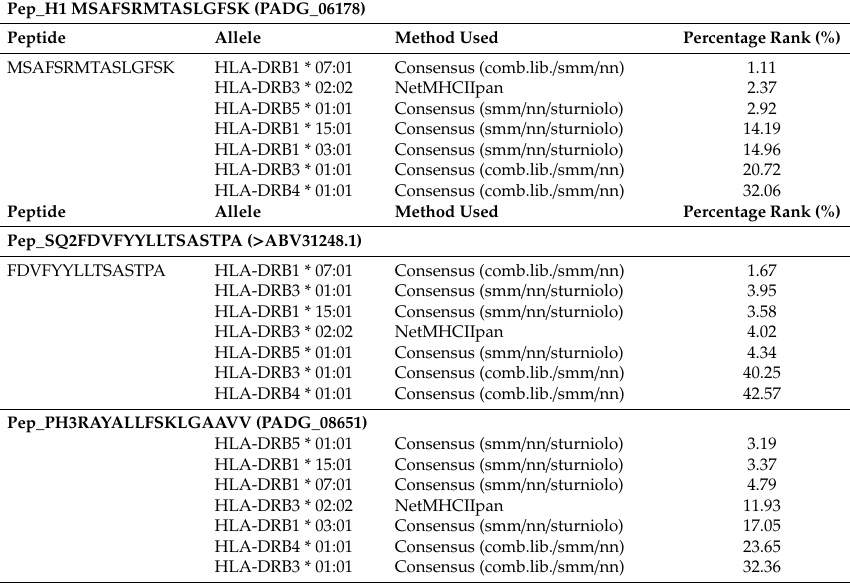
Table 3. Prediction of epitopes for T helper lymphocytes of HLA class II alleles.